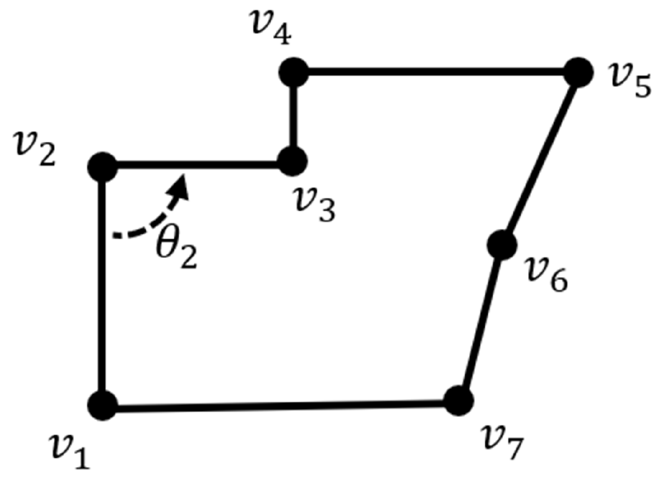
Table 1. Parameter description.